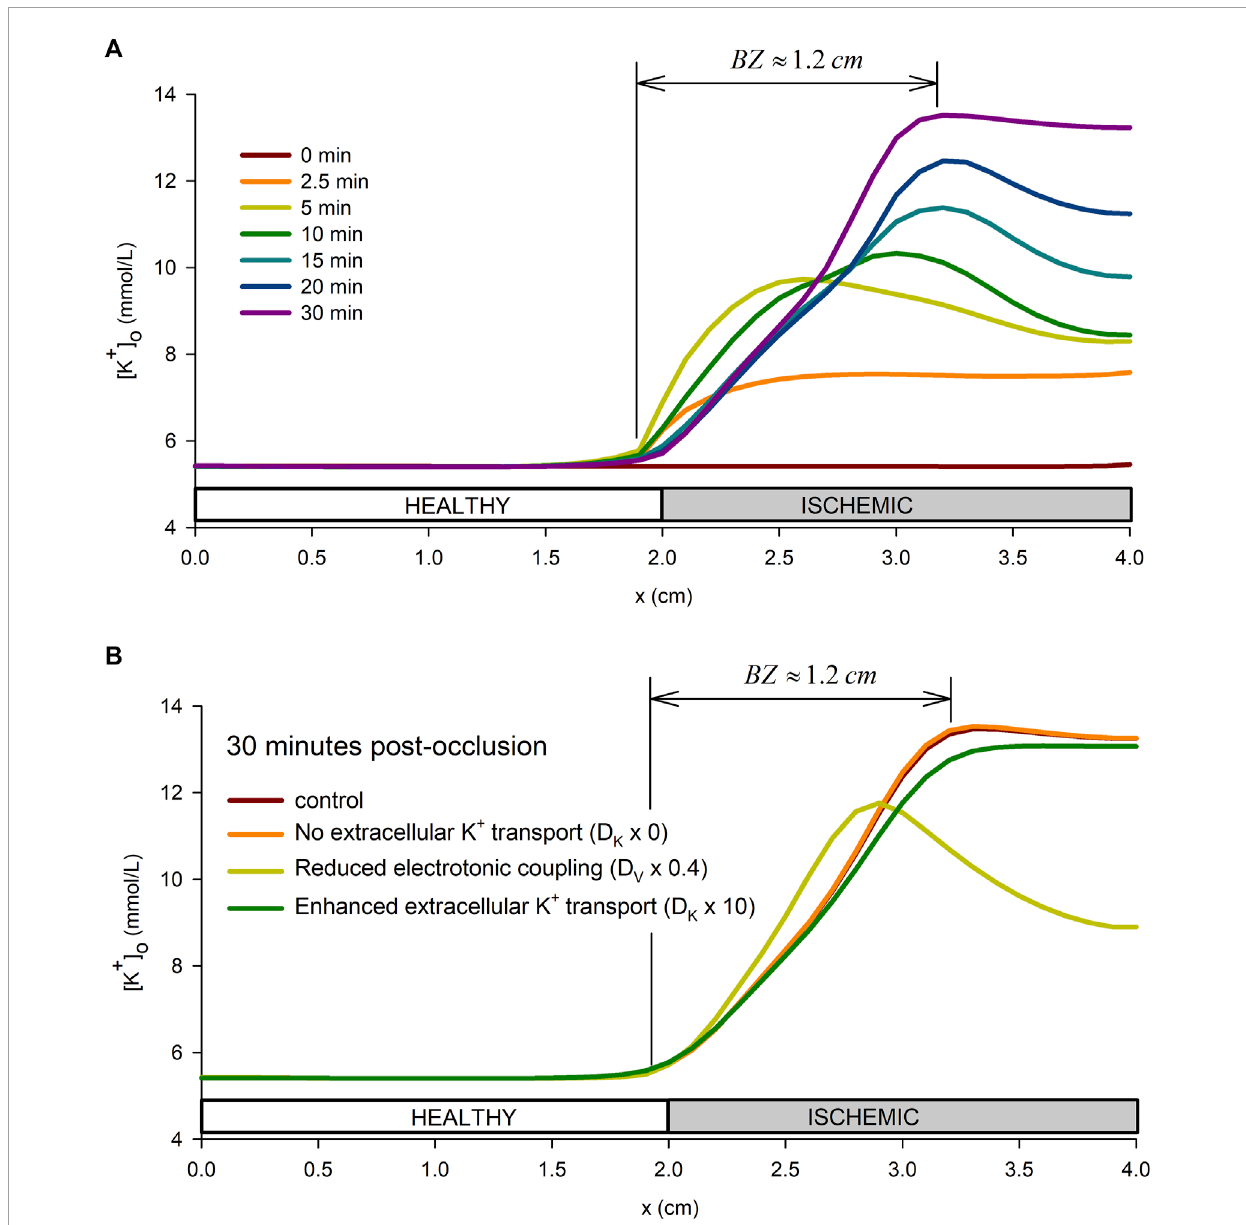
FIGURE 6 Spatial profile of extracellular potassium accumulation. (A) : spatial profile in the tissue preparation at different times from the onset of ischemia. (B) : influence of the tissue conductivity and extracellular potassium diffusion coefficient on the extracellular potassium spatial profile at 30 min from the onset of